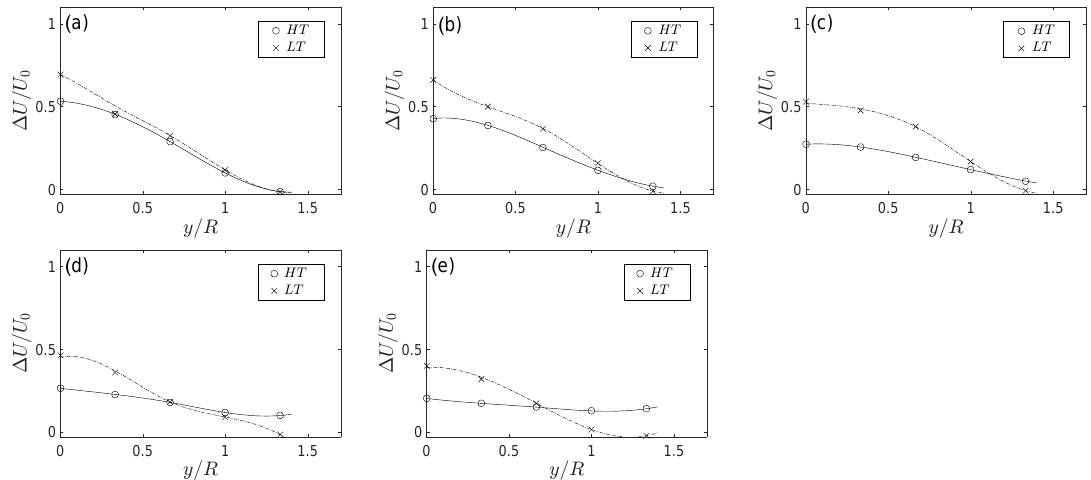
Figure 2. Selected profiles of mean velocity deficit ∆ U / U 0 within the near wake region. ( a ) x / d = 2; ( b ) x / d = 3; ( c ) x / d = 5; ( d ) x / d = 6; ( e ) x / d = 8. HT: high-turbulence; LT: